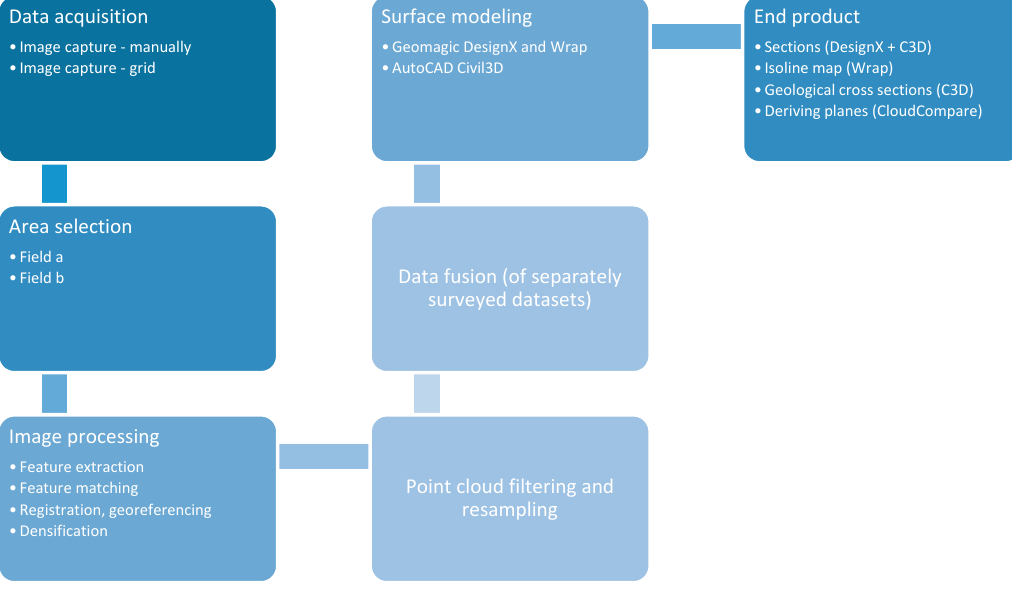
Figure 6. Major steps of data processing from UAV and TLS to surface modelling and geological applications.